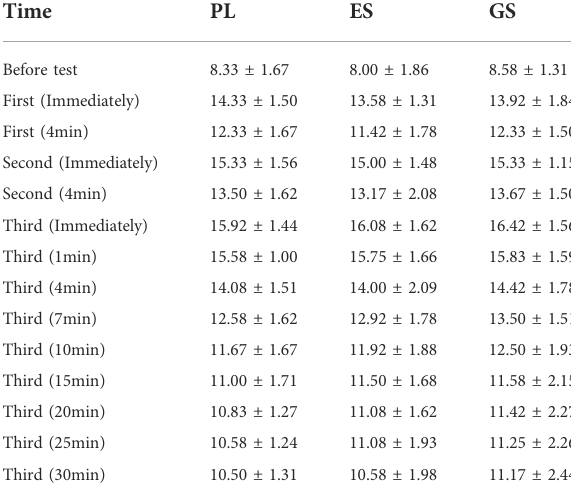
TABLE 3 RPE in three conditions at each